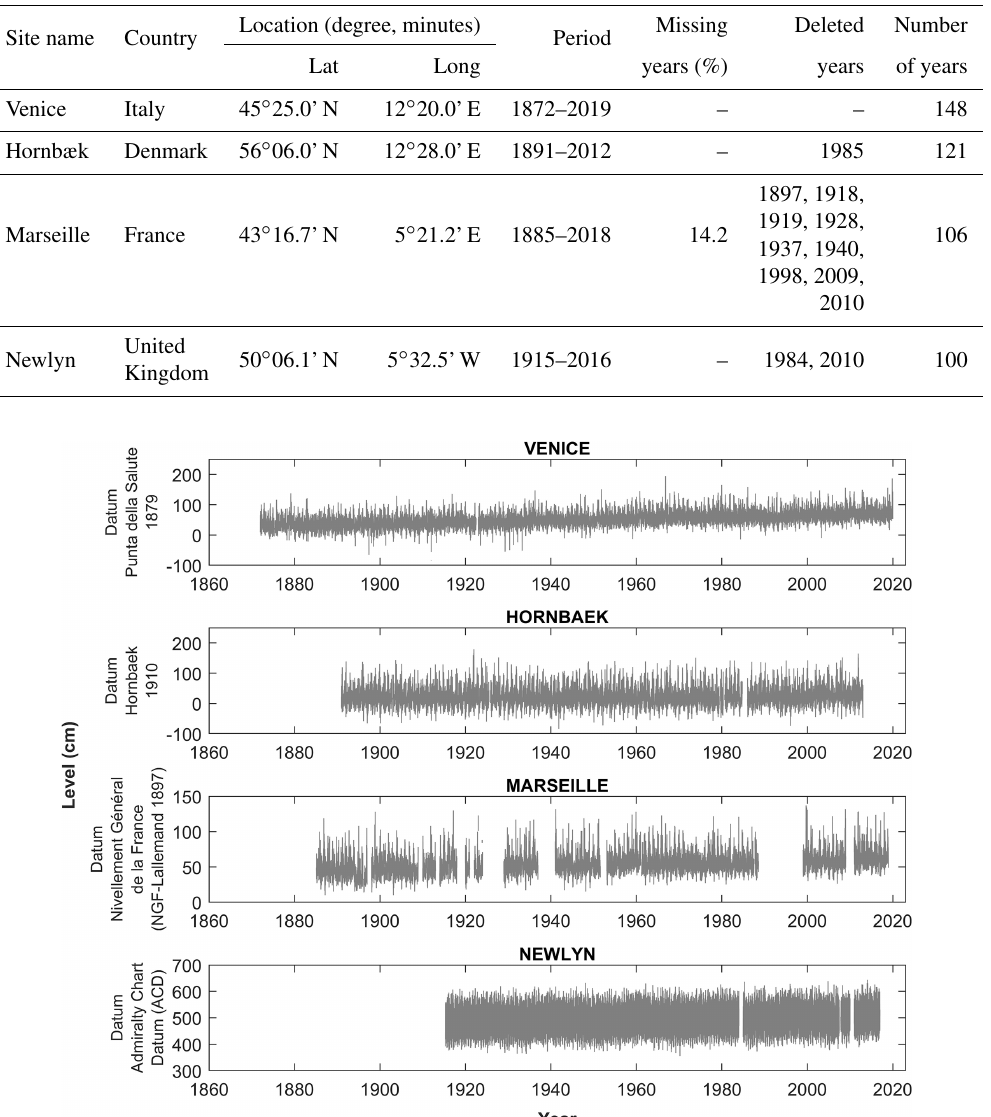
Table 1. Information of sea-level data used in this application.